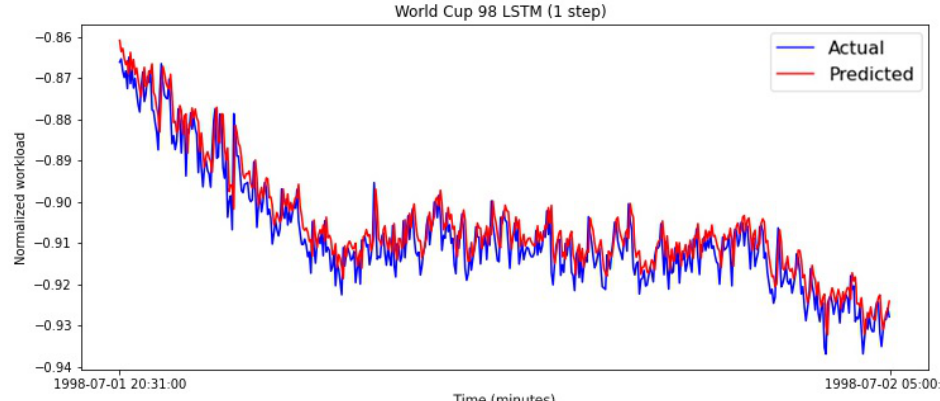
Figure 14. Forward LSTM with one-step prediction on the testing set (from 1 July 1998 20:31:00 to 2 July 1998 05:00:00).